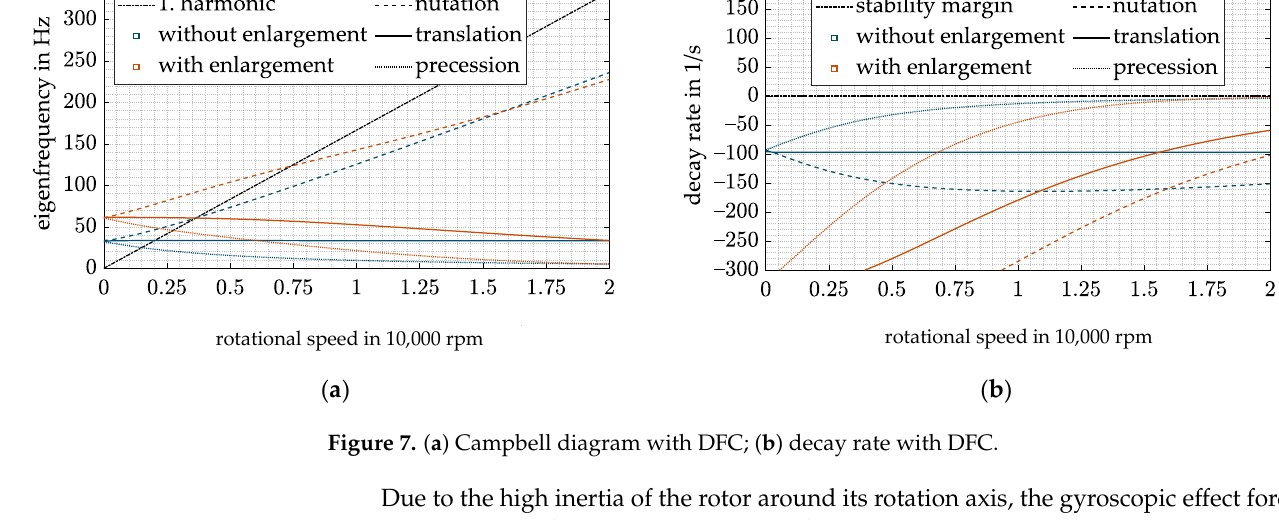
Figure 8. ( a ) Campbell diagram with CFC and C att = 0.5 ; ( b ) decay rate with CFC and C att = 0.5 .